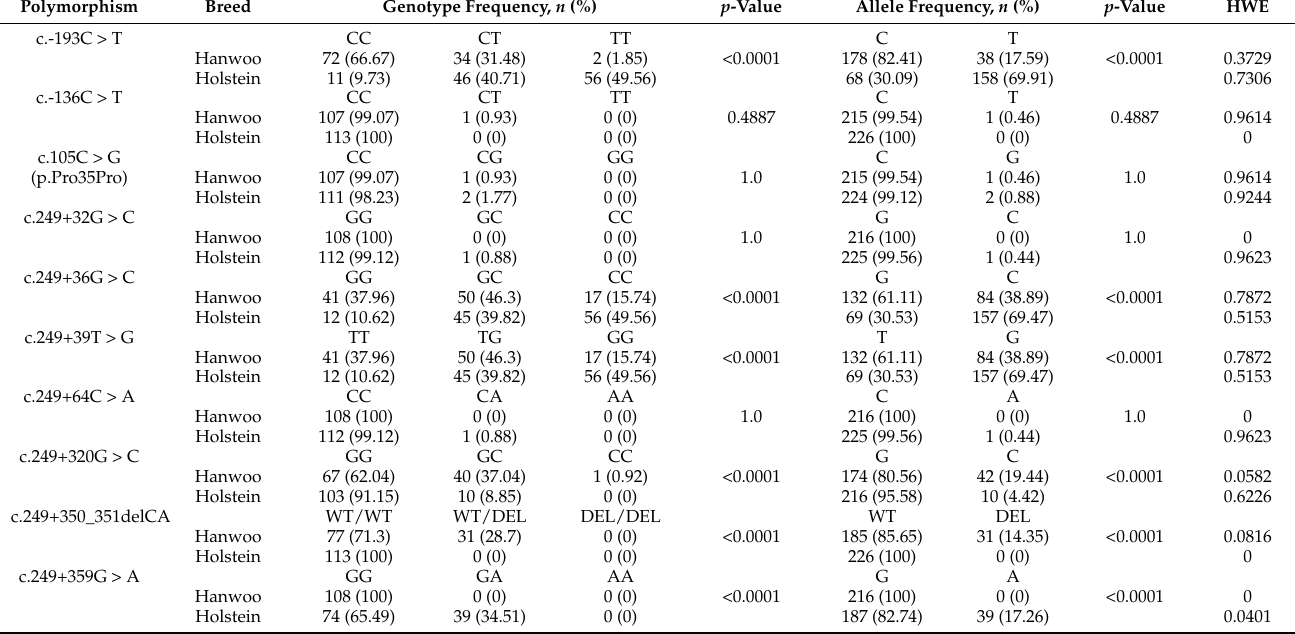
Figure 1. Gene map and polymorphisms of the bovine interferon-induced transmembrane protein 3 ( IFITM3 ) gene on chromosome 29. The open reading frames (ORFs) in exon 1 and exon 2 are marked with black blocks, and white blocks represent the 5′ and 3′ untranslated regions (UTRs). The outlined horizontal bars indicate the sequenced regions. The 23 novel polymorphisms found in this study are indicated by arrows above the gene.